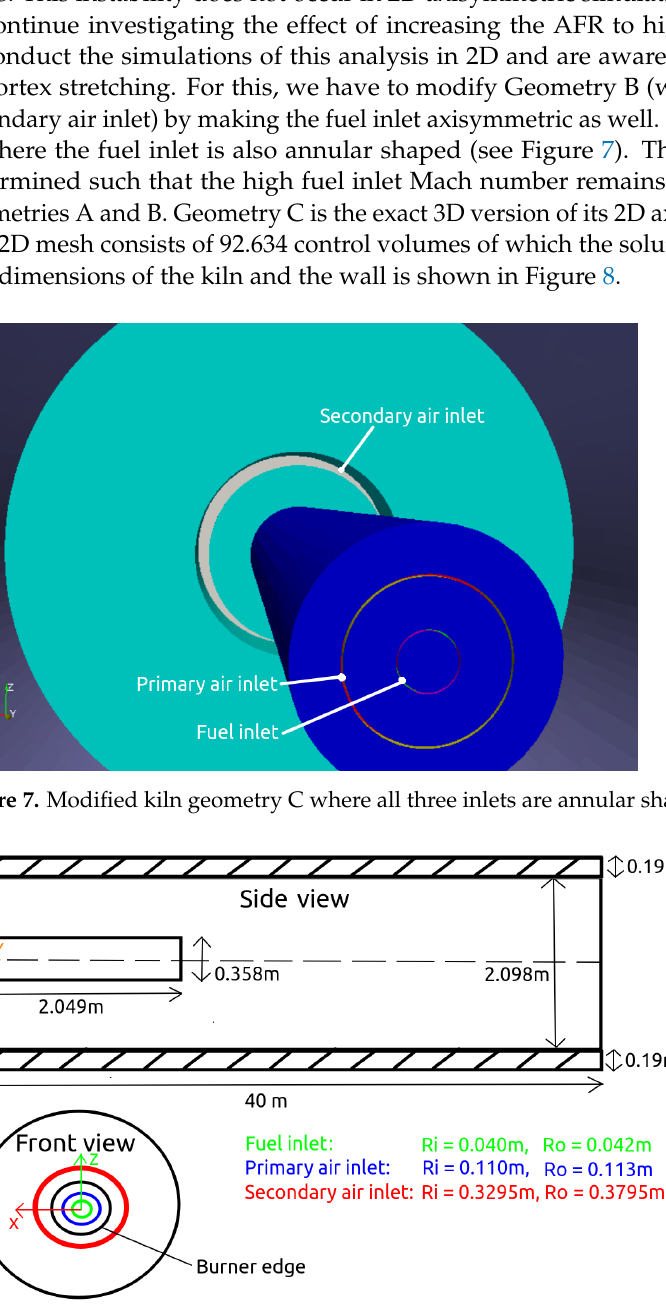
Figure 8. Dimensions (not to scale) of the modified kiln geometry C where all three inlets are annular